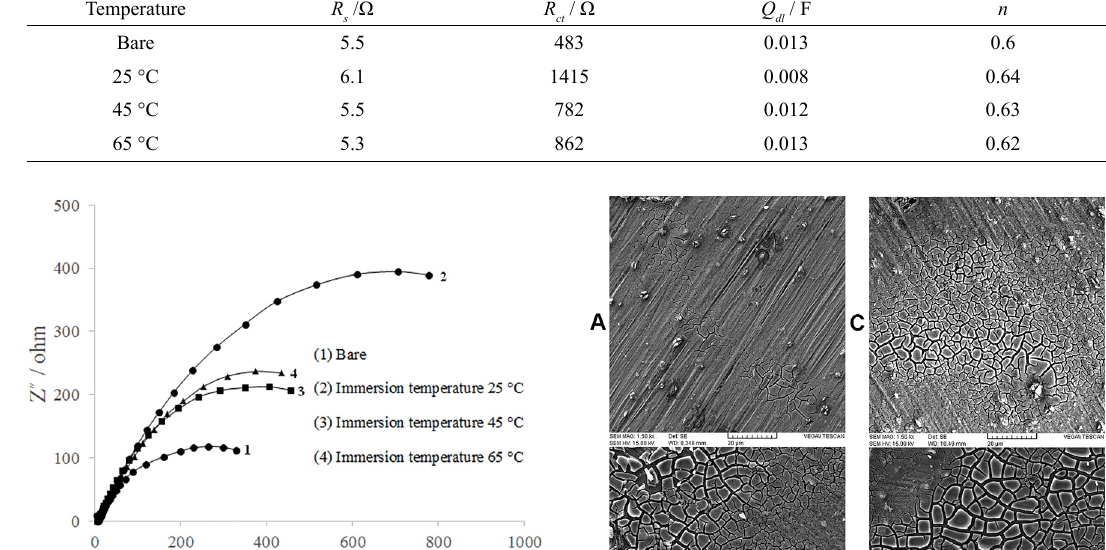
Table 4. Impedance parameters of different operating temperature for the cerium coatings in 3.5 wt. % NaCl solution. Coatings were prepared by 60 s immersion time in cerium solution.